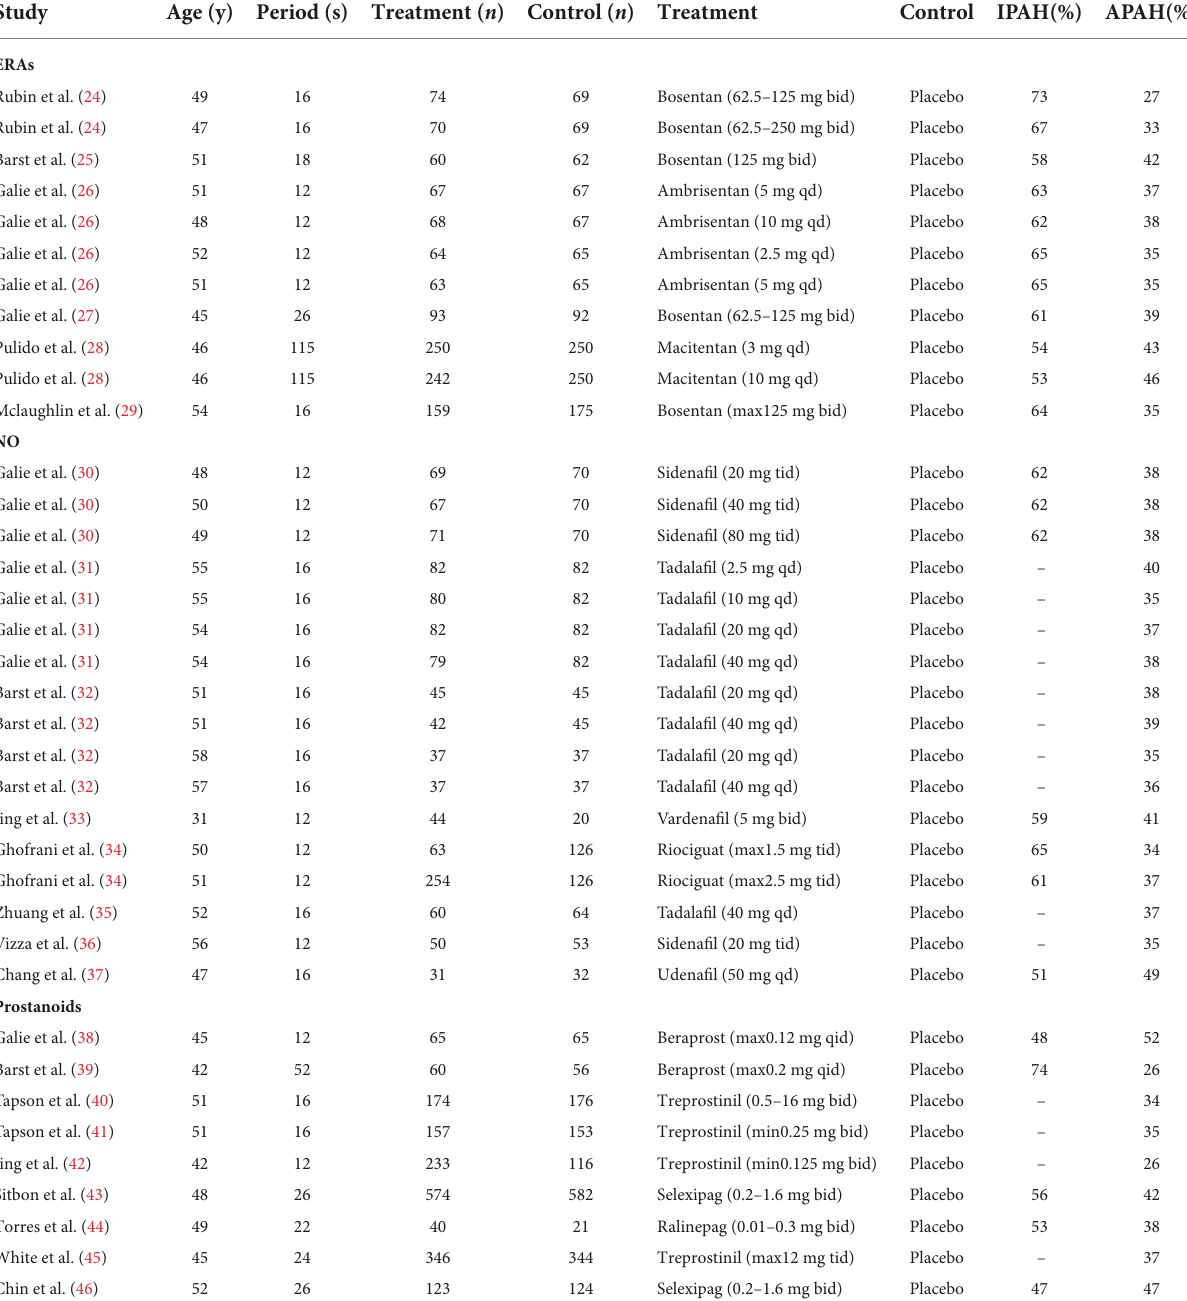
TABLE 2 Characteristics of the studies included in the meta-analysis.